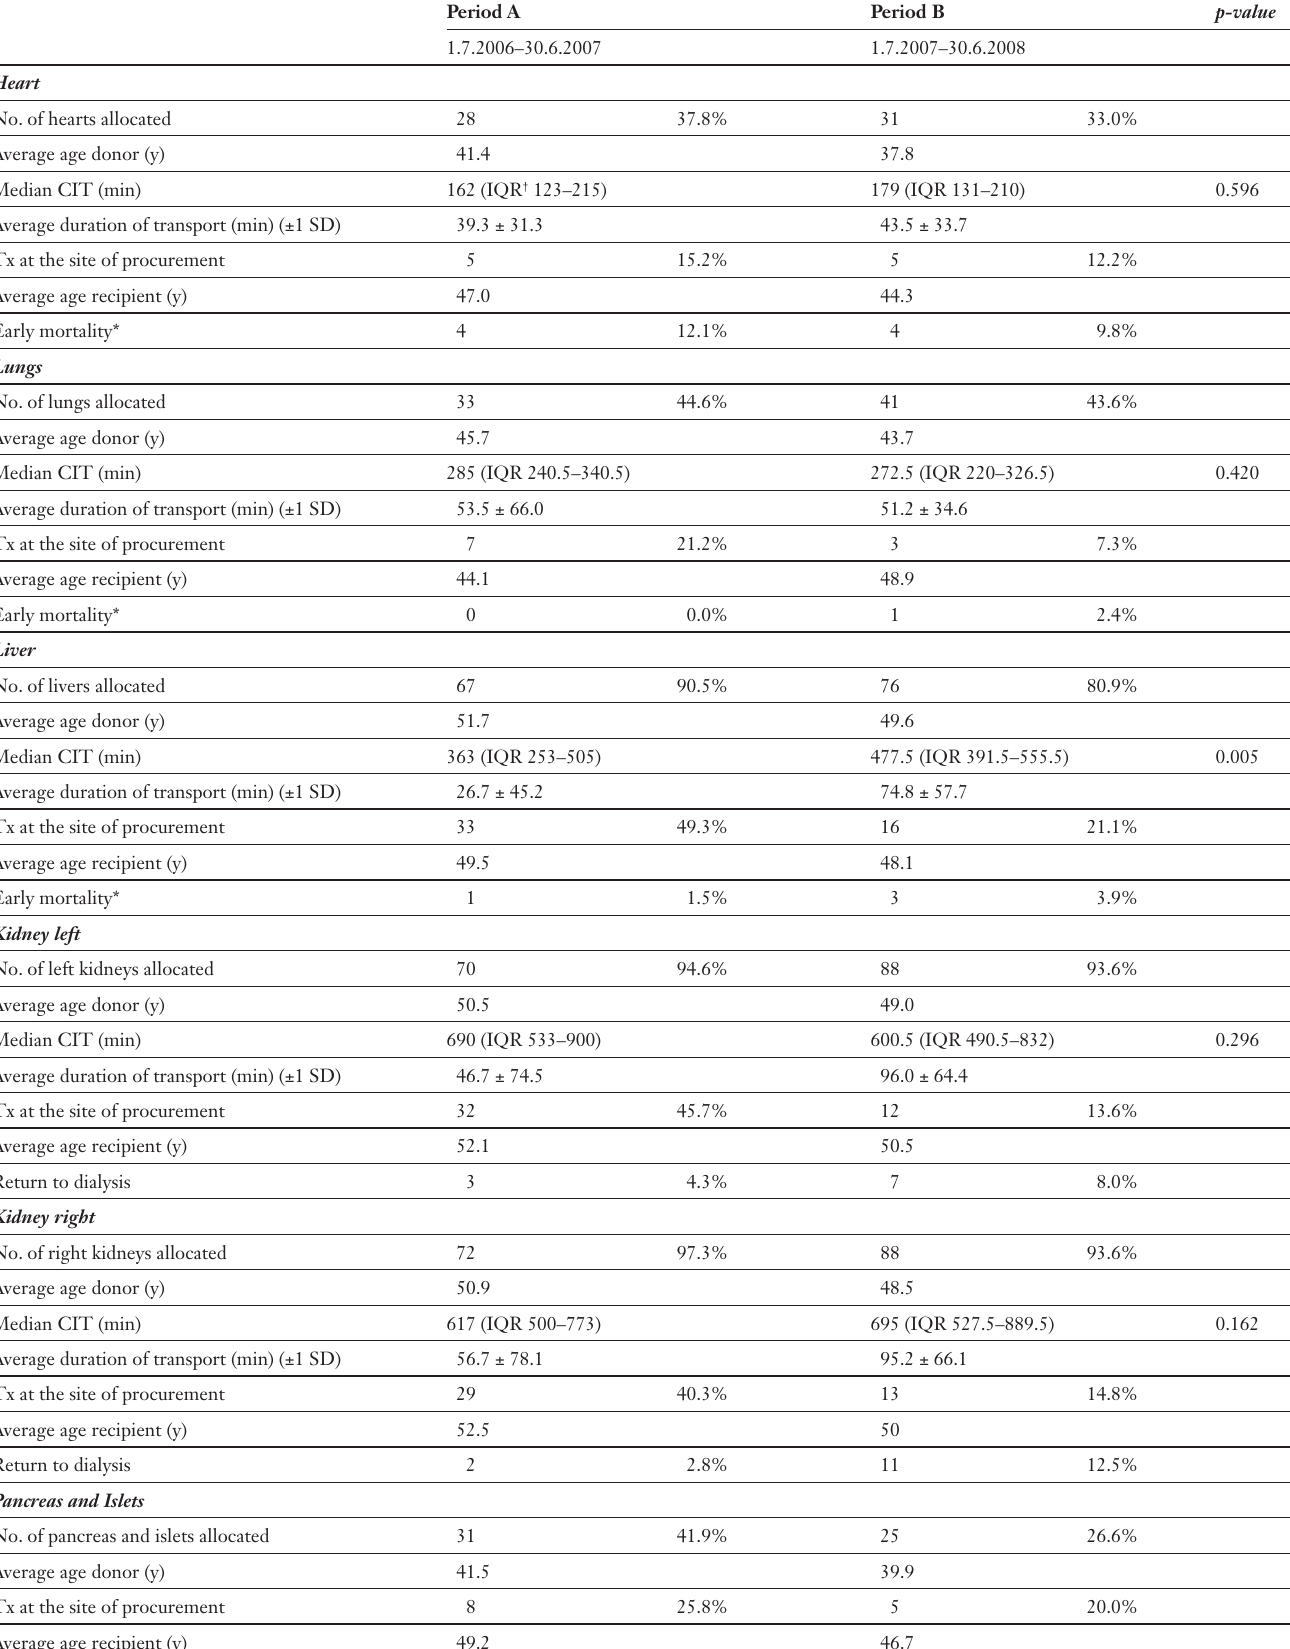
Results displayed by type of